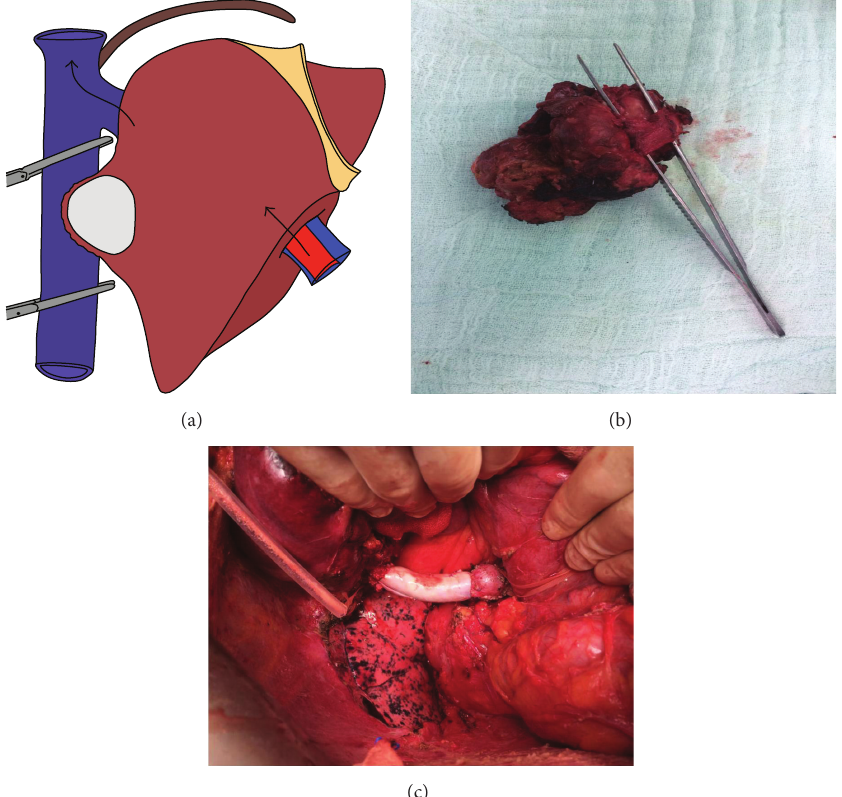
Figure 2: (a) A schematic drawing of isolated vena cava clamping. (b) Completely resected specimen (invaded IVC segment that was resected is included). (c) Reconstructed IVC: right diaphragm resection was performed and right lung can be seen.